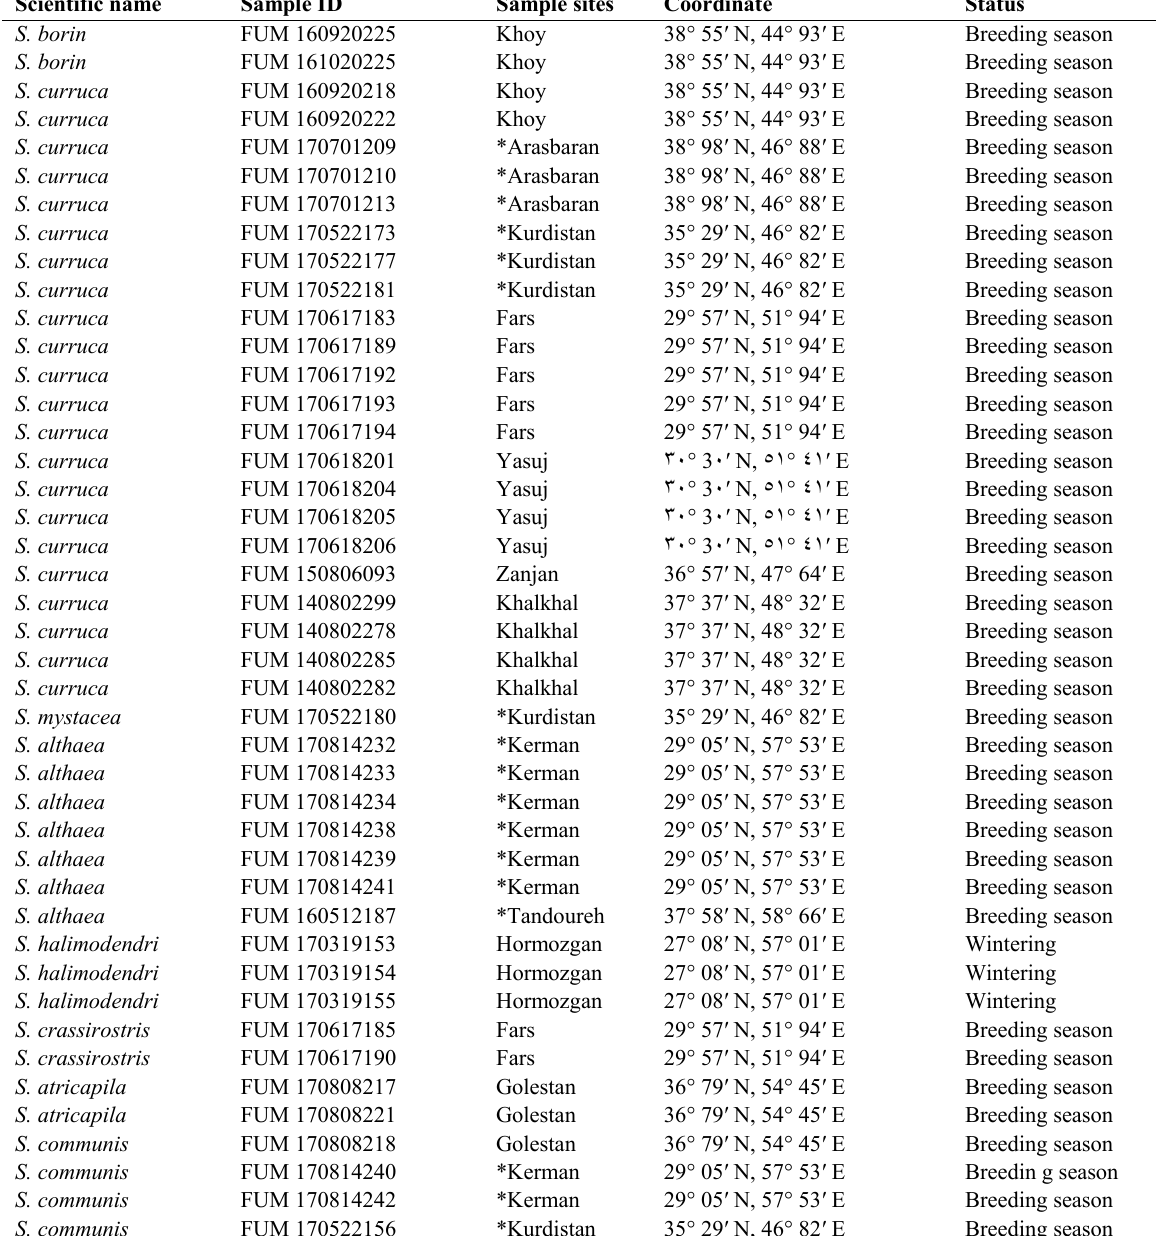
Table 1 . The information of Iranian Sylvia Warblers